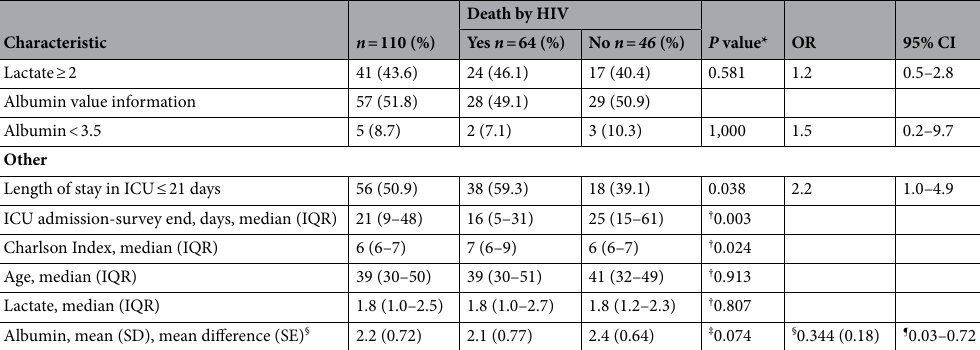
Table 1. Bivariate analysis of mortality according to demographic, clinical and laboratory characteristics of the patients upon admission to the ICU. HIV Human immunodeficiency virus, ICU intensive care unit, HAART Highly active antiretroviral therapy, AIDS Acquired immunodeficiency syndrome, IRIS Immune reconstitution inflammatory syndrome, ARDS acute respiratory distress syndrome, IQR interquartile range, SD standard deviation, SE standard error. a Prognostic markers of HIV-1 infection. * χ 2 test and Fisher exact test, † Mann–Whitney U test, ‡ Independent samples τ-test. P < 0.05. OR odds ratio; 95% CI, 95% confidence interval, § Mean difference, ¶ 95% confidence interval of mean difference.